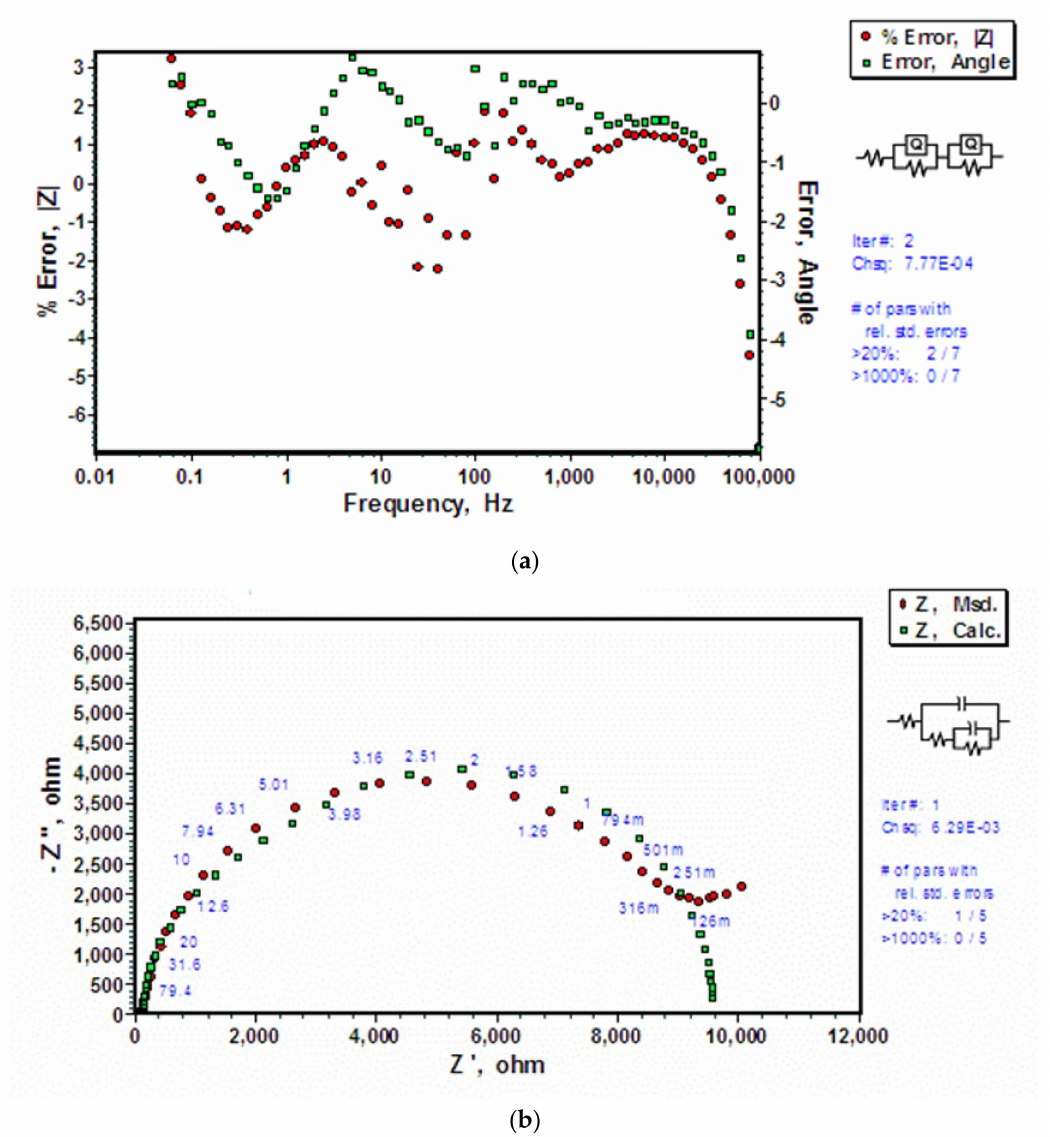
Figure 5. Validity checks for EIS data for uncoated AZ91D alloy exposed to 0.1 M NaCl solution: ( a ) Error plots for calculated values for |z| and angle for electrical equivalent circuit, R s (Q o R o )(Q dl R dl ), and ( b ) Evidence of Nyquist plot not fitting well with another electrical equivalent circuit, (Rs(CoRo(C dl R dl